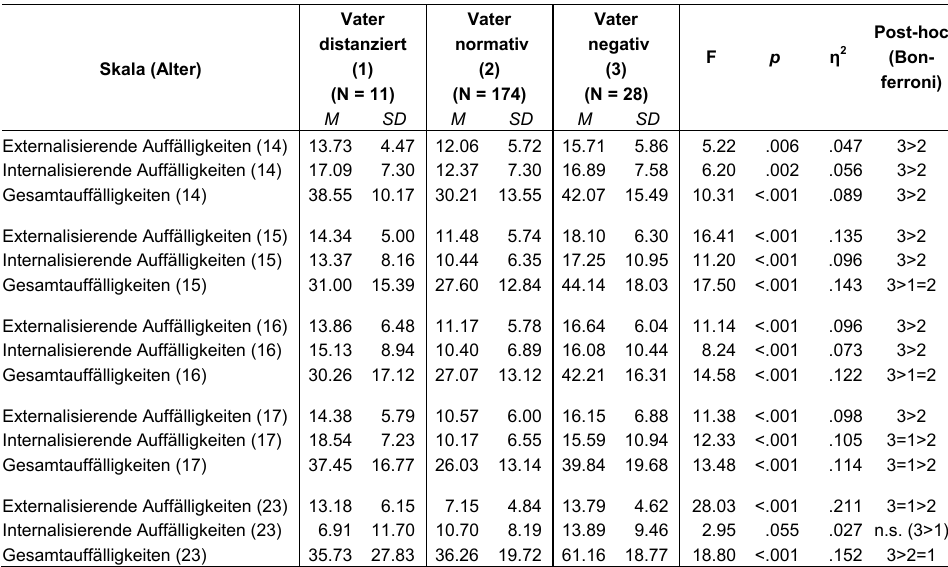
Tabelle 3 : Die Symptombelastung in Jugendalter und jungem Erwachsenenalter